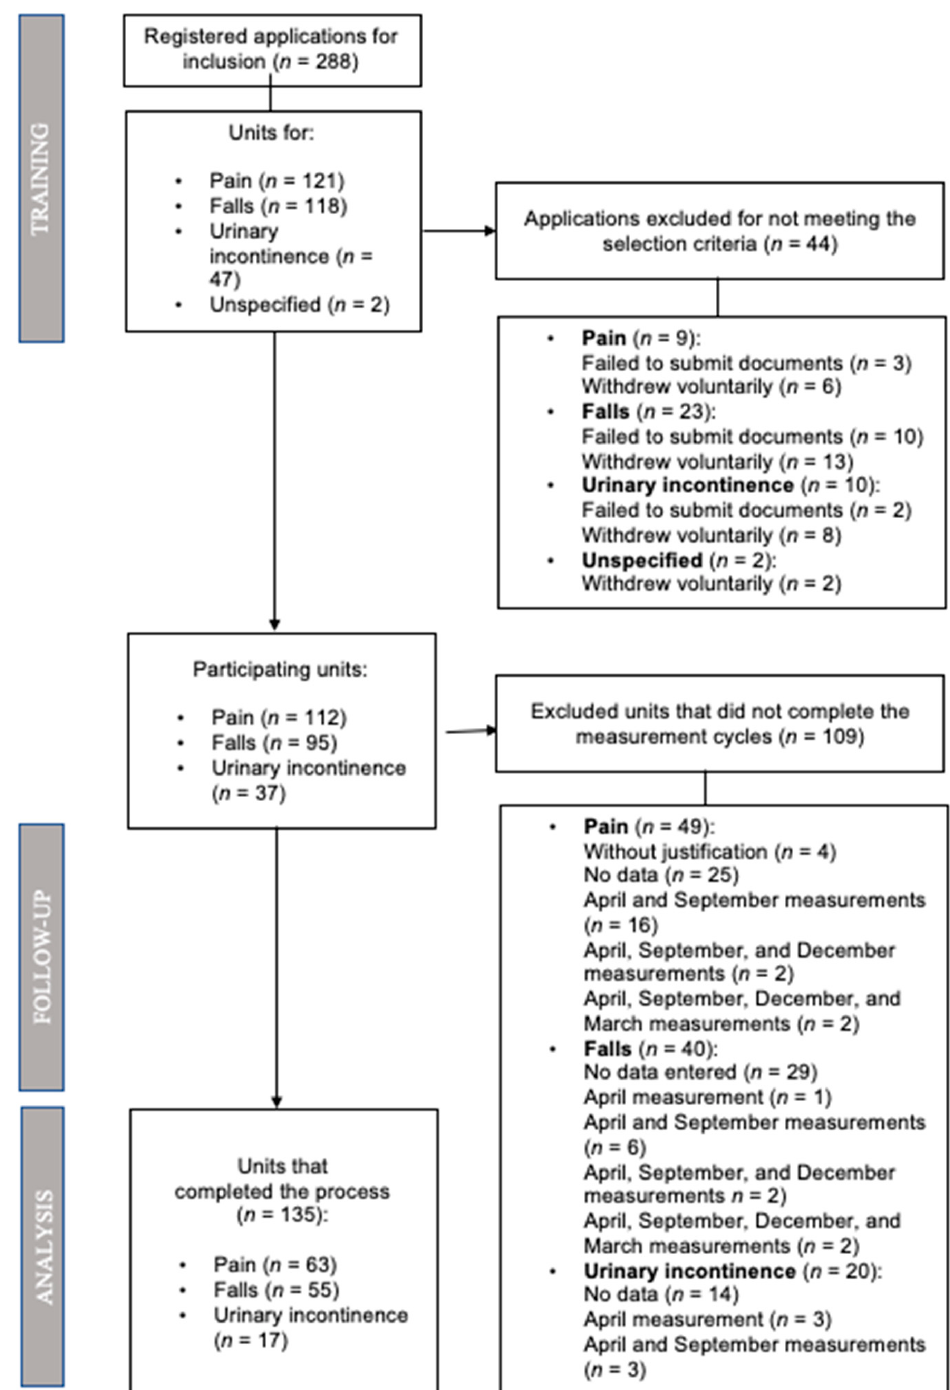
Figure 2. Flow chart of the unit recruitment process in Sumamos Excelencia. A total of 22,114 patients were analyzed, whose distribution and characteristics are reflected in Table 1.